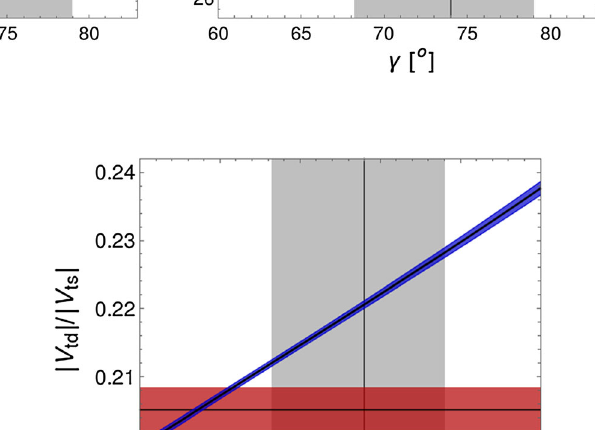
Fig. 4 Left: (cid:3) M d (red) and (cid:3) M s (green) as functions of normalised to their experimental values. The 1 σ -band includes all other uncertainties. Right: (cid:3) M /(cid:3) M s d as function of